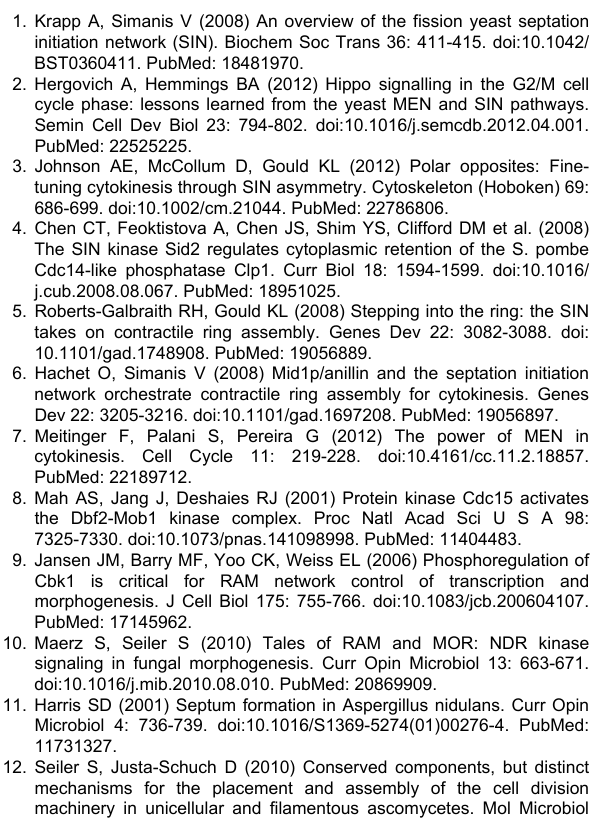
Table S1. N. crassa strains used in this study.